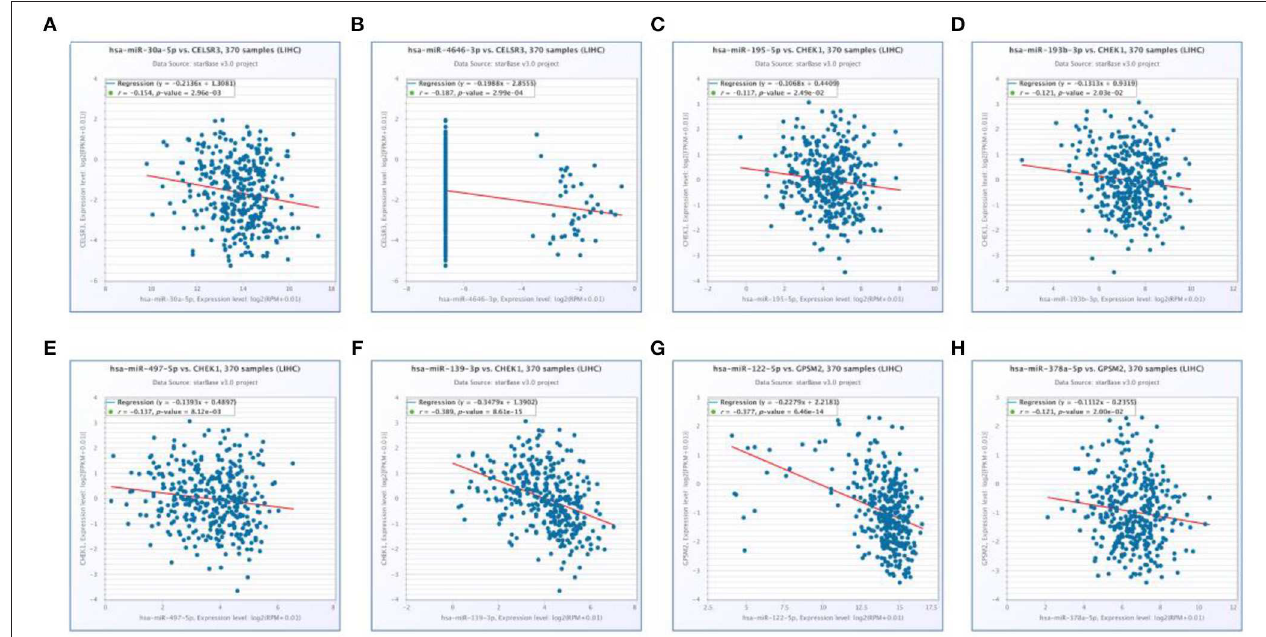
FIGURE 4 | Significantly correlated mRNA-miRNA pairs determined by starBase database. (A) Expression of hsa-mir-30a-5p was negatively associated with CELSR3 expression; (B) expression of hsa-mir-4646-3p was negatively associated with CELSR3 expression; (C) expression of hsa-mir-195-5p was negatively associated with CHEK1 expression; (D) expression of hsa-mir-193b-3p was negatively associated with CHEK1 expression; (E) expression of hsa-mir-497-5p was negatively associated with CHEK1 expression; (F) expression of hsa-mir-139-3p was negatively associated with CHEK1 expression; (G) expression of hsa-mir-122-5p was negatively associated with GPSM2 expression; (H) expression of hsa-mir-378a-5p was negatively associated with GPSM2